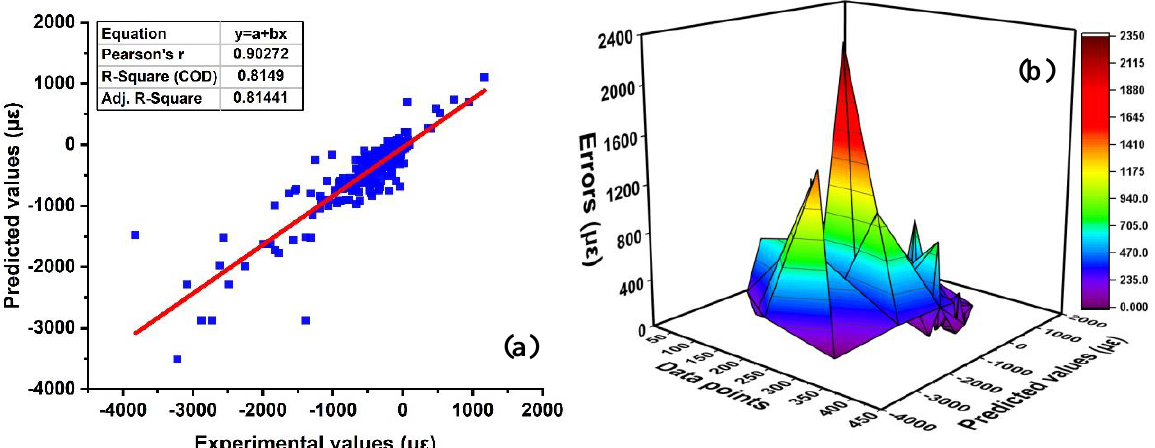
Figure 4. Support vector regression (SVR); ( a ) regression analysis with experimental and predicted result; ( b ) Errors of experimental and targeted via SVR.